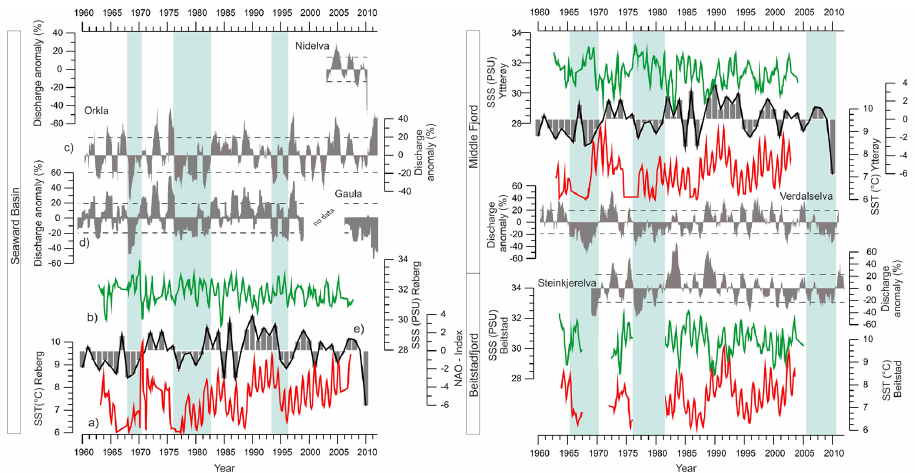
Fig. 2. Hydrological and climatic data at mooring stations Røberg, Ytterøy and Beitstad at 10 m water depth from 1963 to 2005 with (a) red lines: 15 pt. running average of monthly temperature data, (b) green lines: 7 pt. running average of monthly salinity data, (c) grey shaded graphs: annual running average of river discharge rate anomalies (m 3 yr − 1 in % below/above the 50yr mean value), (d) grey dashed lines: standard deviation of river discharge rates in %; (e) grey black-framed columns: NAO index (Hurrell, 1995); blue columns: negative anomalies of river